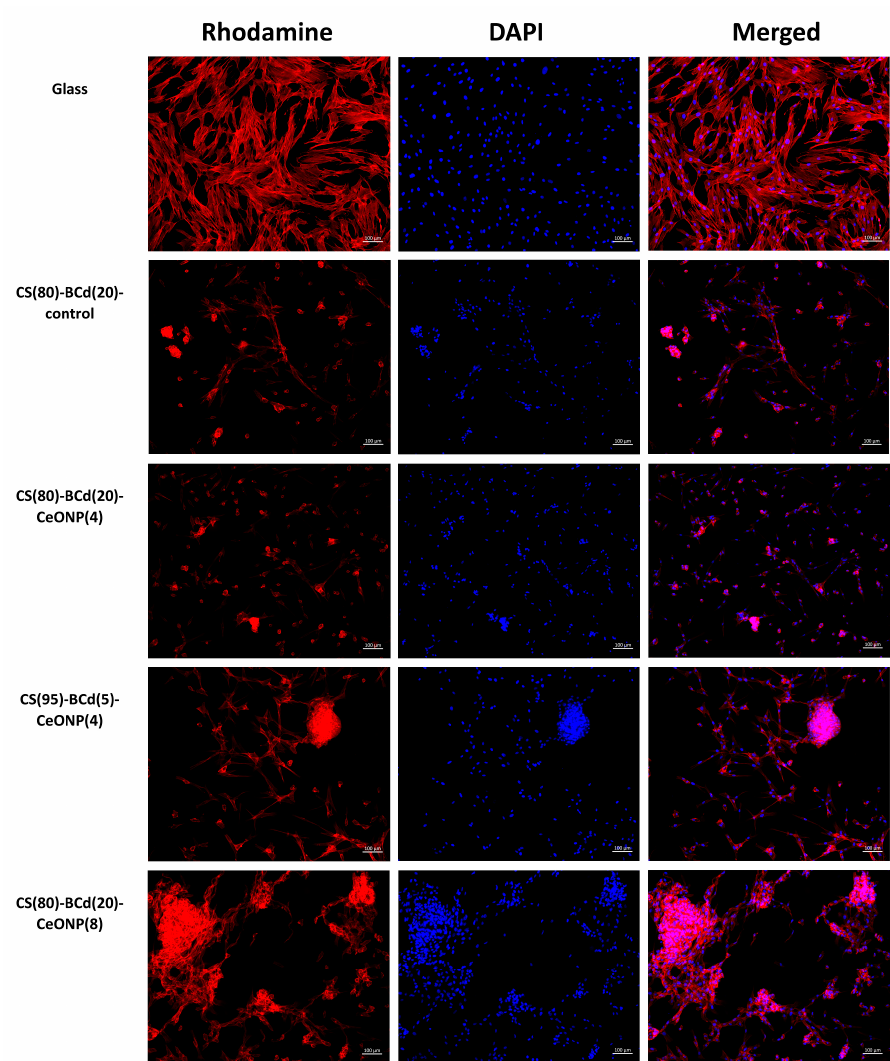
Figure 9. MSCs adhered to the surface of glasses and CS-BCd composite films. Staining of cell cytoskeleton fibrillar actin with Rhodamine-channel fluorochrome visualization, staining of cell nuclei with DAPI (4,6-diamidino-2-phenylindole), combined two-channel image. Magnification × 100.